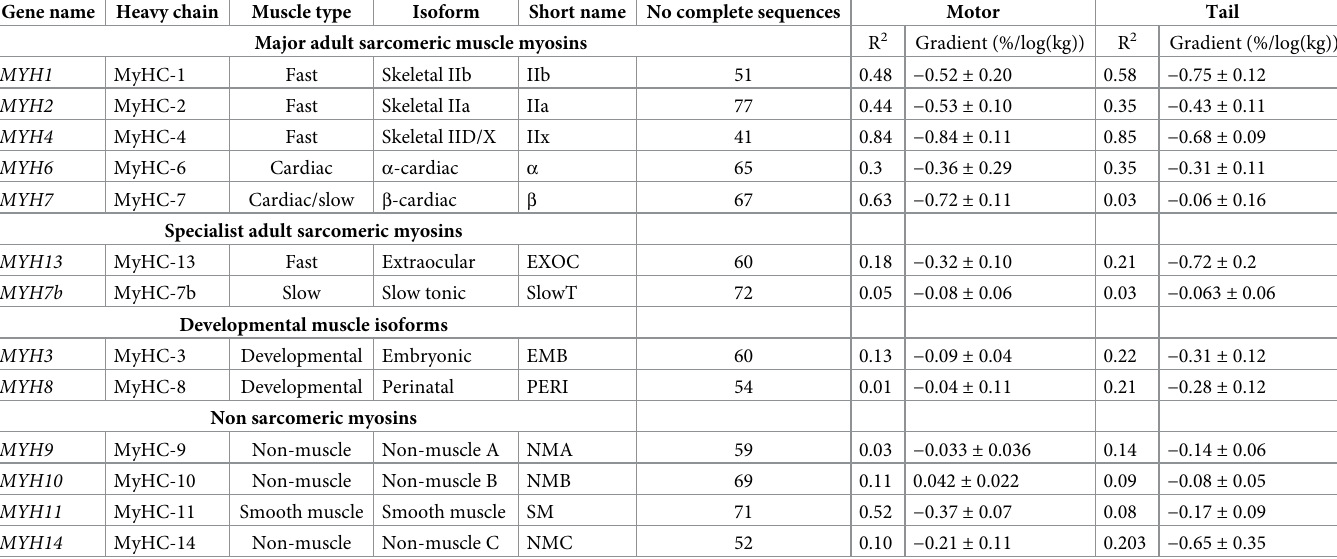
Table 1. Myosin II isoforms